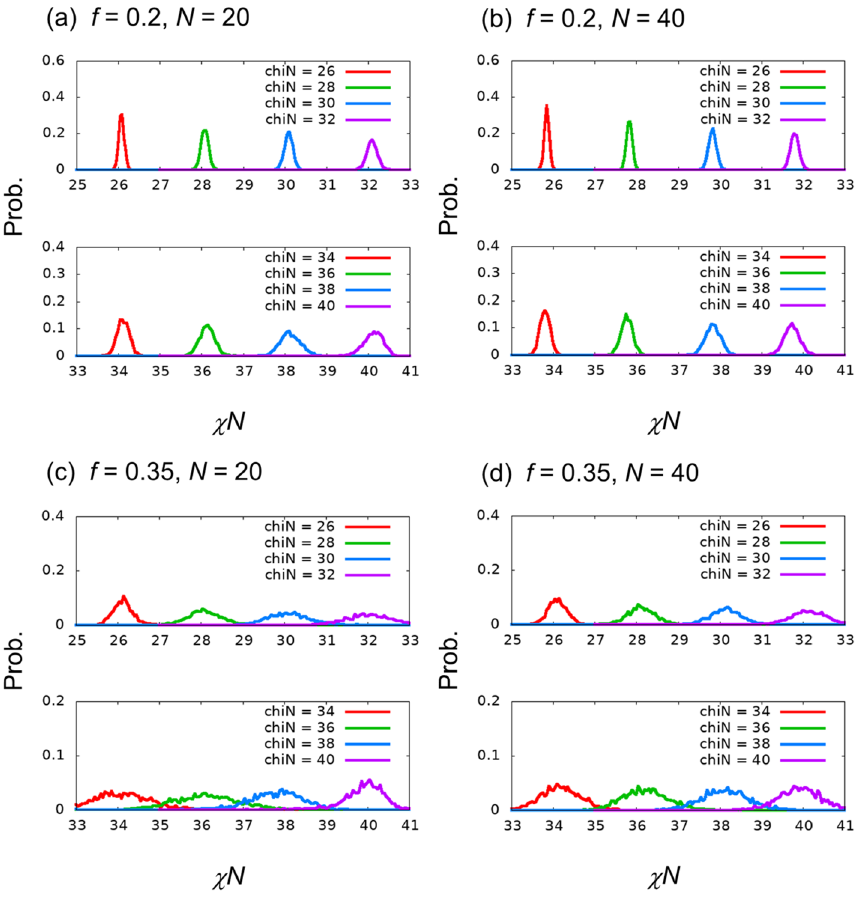
Figure 4. Probability distribution functions of the estimated χ N value for evaluation data generated with same χ N values as the teaching data. Here, the size of each bin was 0.05.